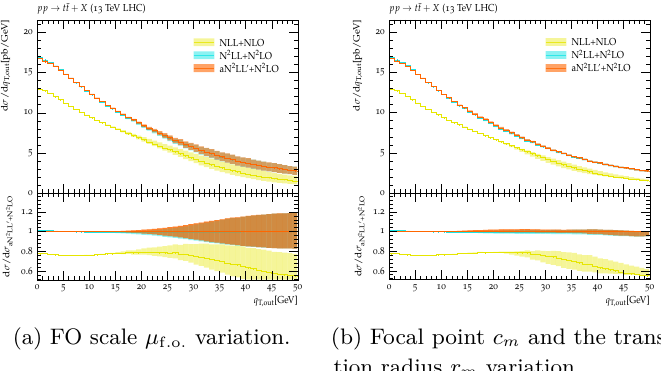
Figure 14 . Dependence on the rapidity scales associated with the beam-collinear and soft sectors of the differential cross section d σ